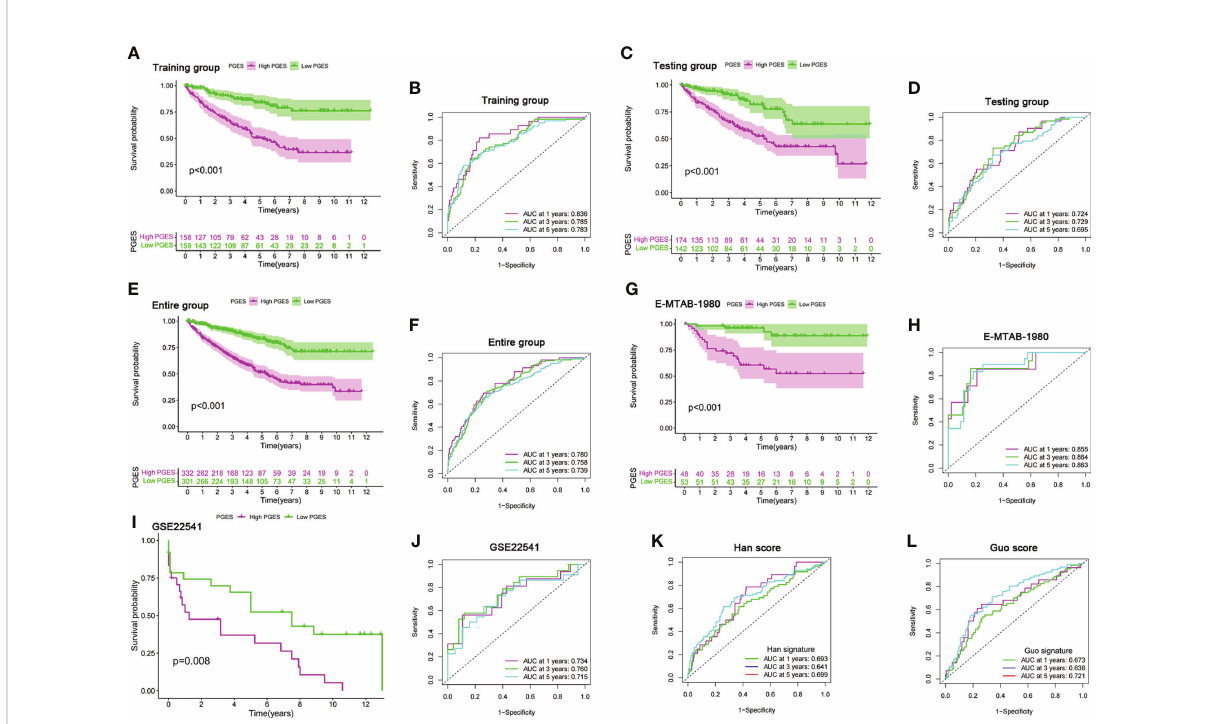
FIGURE 4 Prognostic value of the PGES. (A, B) K-M curve of survival difference and predictive accuracy of PGES in the training group. (C, D) K – M curve of survival difference and predictive accuracy of PGES in the testing group. (E, F) K – M curve of survival difference and predictive accuracy of PGES in the entire group. (G, H) K – M and ROC curves of PGES predicting survival in E-MTAB-1980 dataset. (I, J) K – M and ROC curves of PGES predicting survival in GSE22541 dataset. (K, L) Predictive accuracy of PGES in other studies. PGES, polyamine gene expression